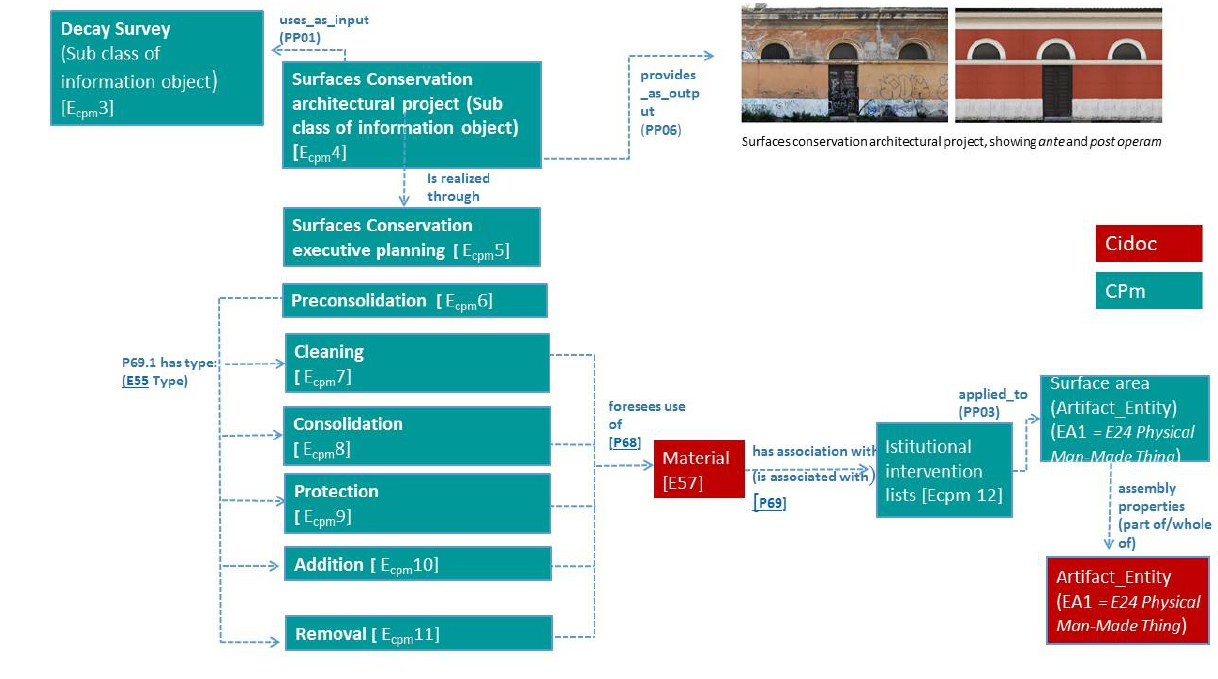
Figure 6. Surfaces conservation project